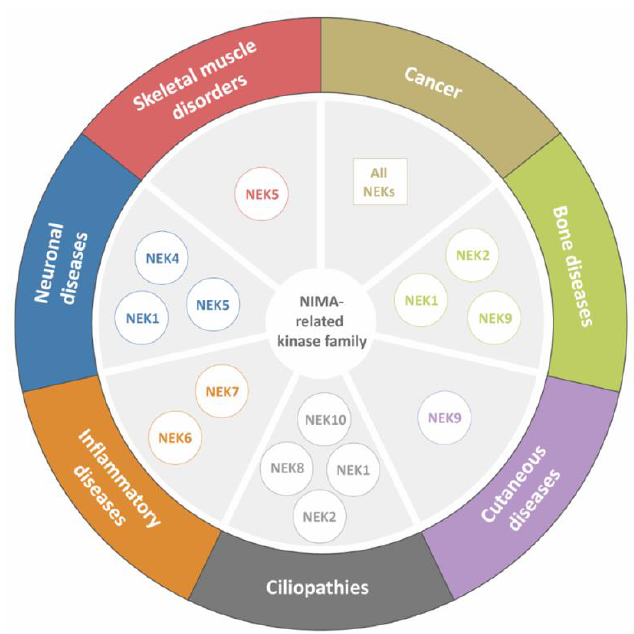
Figure 2. The NIMA-related kinase (NEK) family is involved in various human diseases. The schematic circle shows that the 11 members of the NEK family are related to different human diseases, such as cancer, bone, neuronal, skeletal muscle, inflammatory, cutaneous, and ciliopathic diseases. All NEKs are involved in cancer.